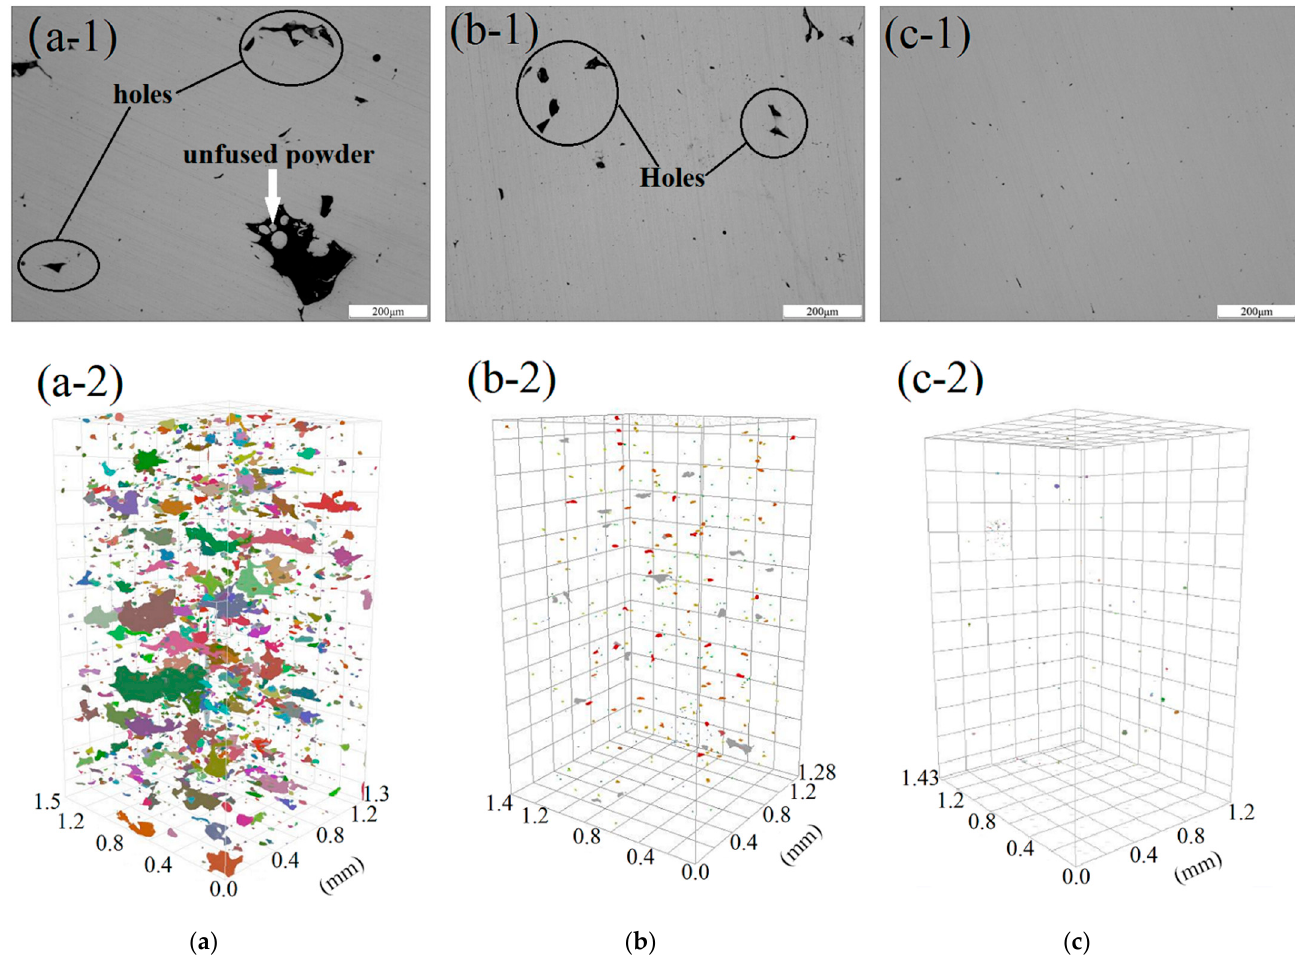
Figure 3. Relative density obtained for different printing parameters (( a ) 210 W, 1300 mm/s, (a-1) 2D, (a-2) 3D; ( b ) 210 W, 900 mm/s, (b-1) 2D, (b-2) 3D; ( c ) 230 W, 1100 mm/s, (c-1) 2D, (c-2) 3D).